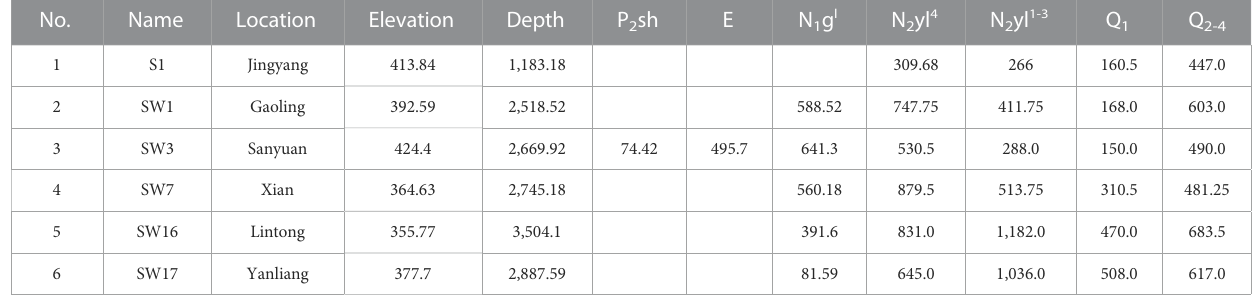
All the units are meters.